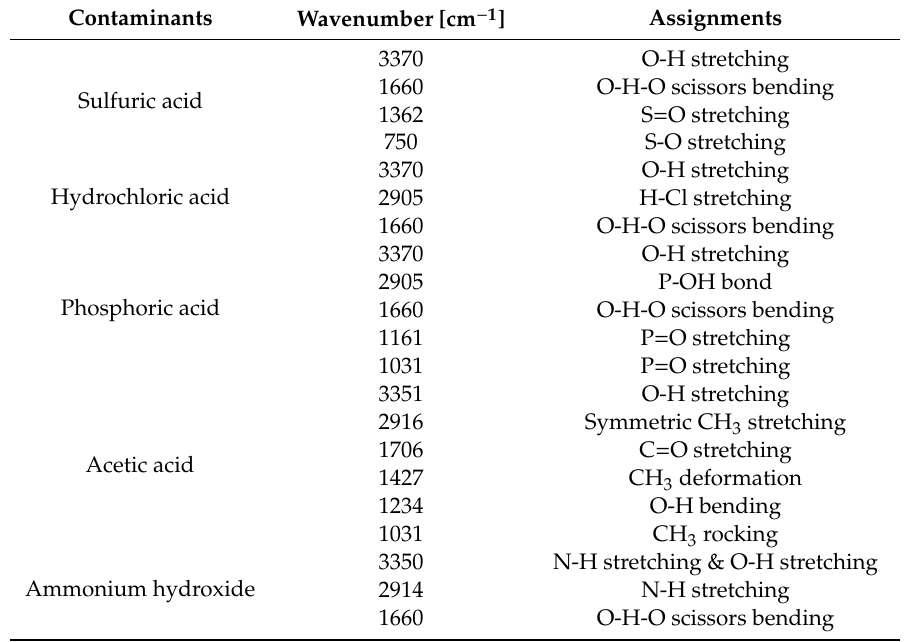
Table 3. FTIR band assignments of acids and alkalis contaminants on poplar [34,46–49]. Contaminants